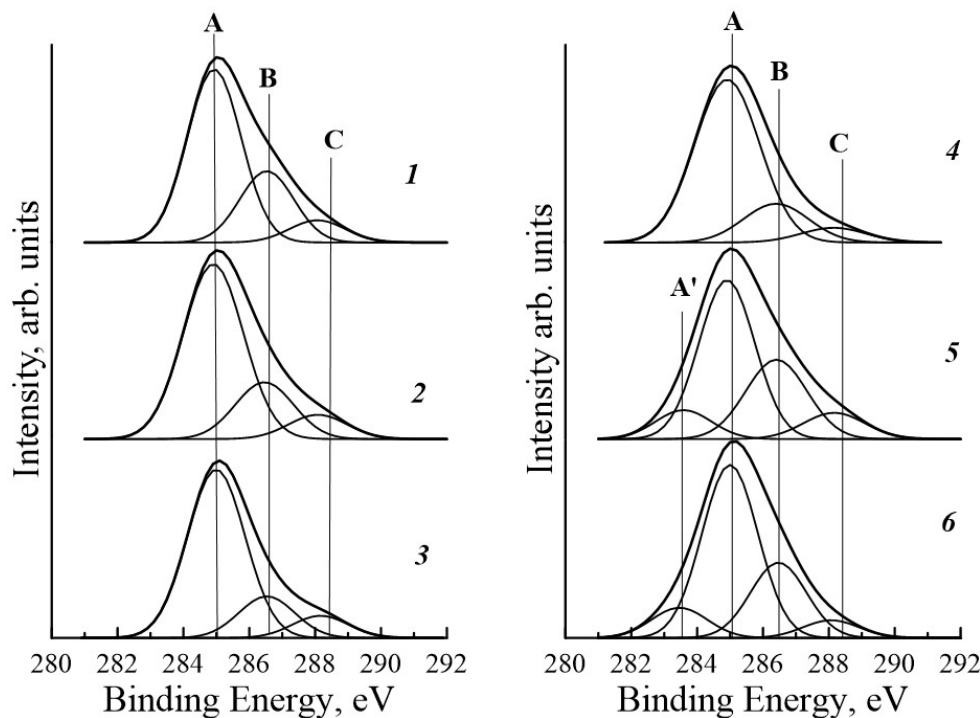
Figure 6. X-ray photoelectron spectra of internal layers C1s of chitosan ( 1 ) and composite films containing 0.1 ( 2 ), 0.5 ( 3 ), 1.0 ( 4 ), 2.5 ( 5 ), and 3.0 ( 6 ) wt.% of SWCNT. Peak A—C-H (285.0 ± 0.2 eV); peak B—C-C (286.4 ± 0.2 eV); peak C—C-O-H, C-O-O-H (288.4 ± 0.2 eV), 283.42 ± 0.2 eV (peak A’). Table 1. Mechanical characteristics of the chitosan-based composite films containing SWCNT. SWCNT Content, Wt.